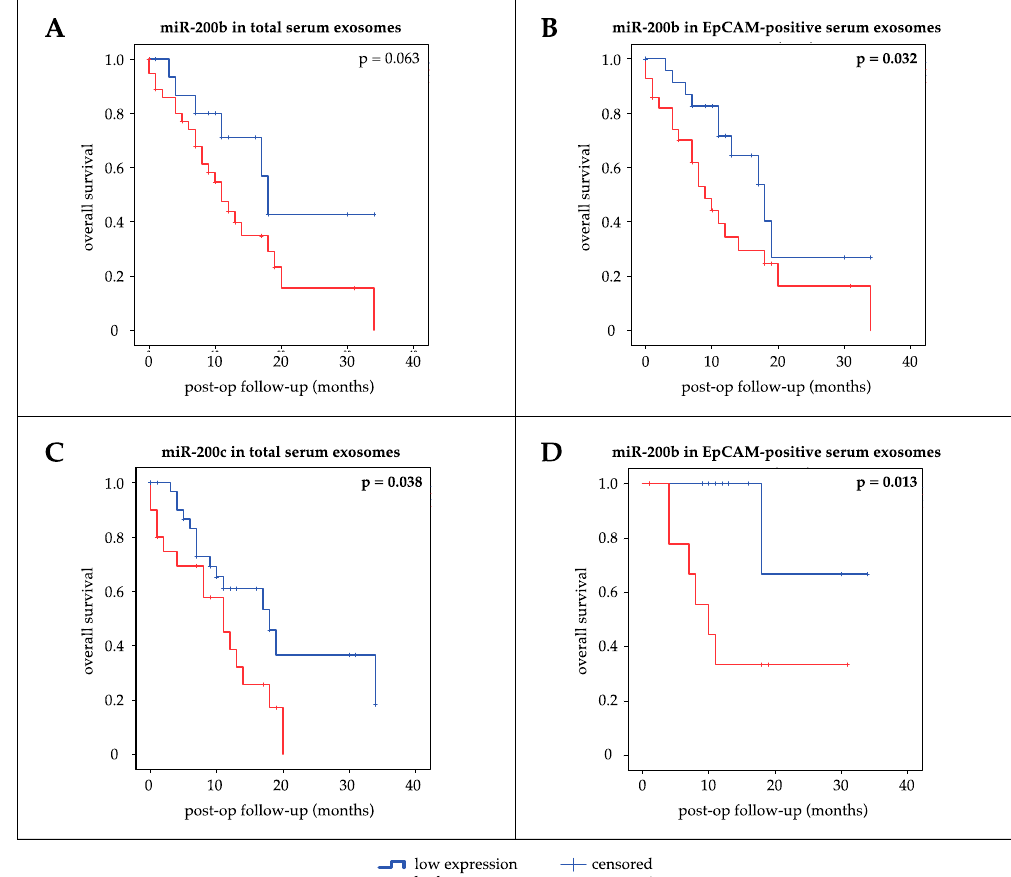
Figure 3. Kaplan–Meier curves for univariate survival analysis. Bold values indicate significance ( p ≤ 0.05, log-rank test). Prognostic impact on overall survival of all PDAC patients of ( A ) miR-200b in total serum exosomes, ( B ) miR-200b in EpCAM-positive serum exosomes, ( C ) miR-200c in total serum exosomes. ( D ) Prognostic impact of miR-200b in EpCAM-positive serum exosomes on overall survival of patients treated with curative